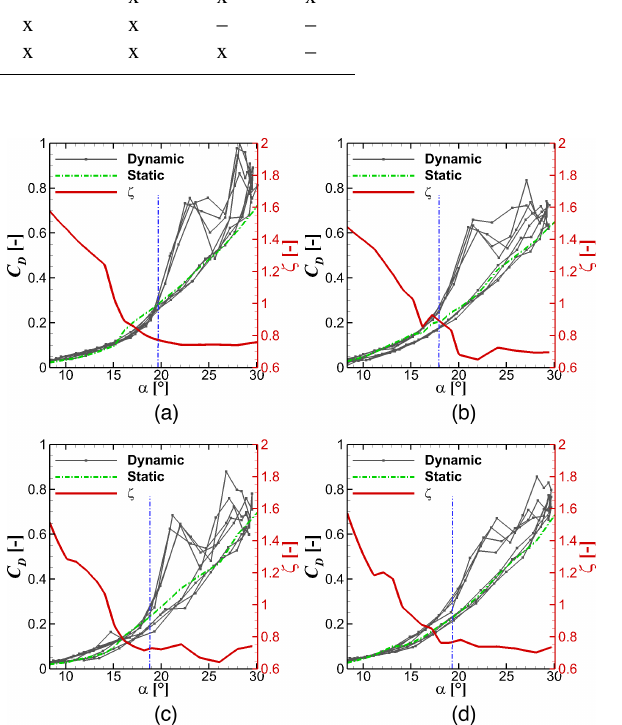
Figure 3. Relation between drag hysteresis in the stall regime with weighted separation parameter ζ for four airfoils. From (a) to (d) : S801 (13.5%), NACA4415 (15%), S809 (21%) and S814